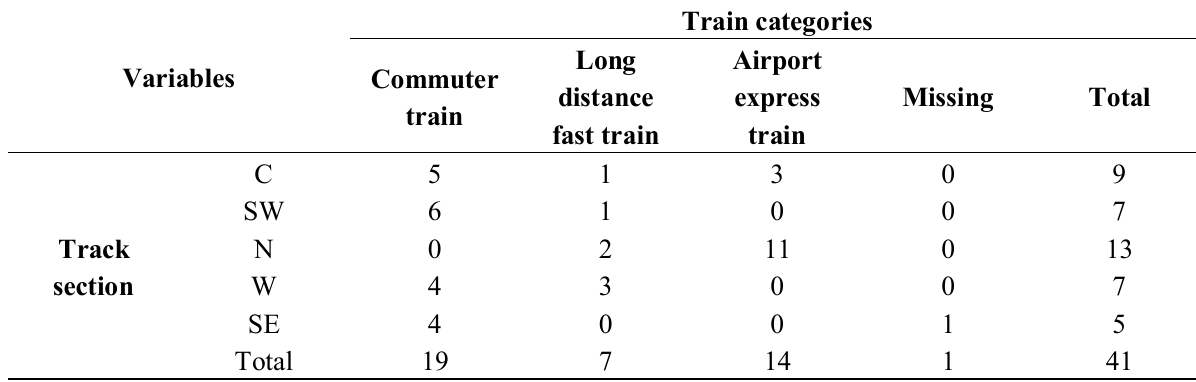
Table 4. Fatal train-person collisions by track sections and train categories on railway property in the greater Stockholm area,